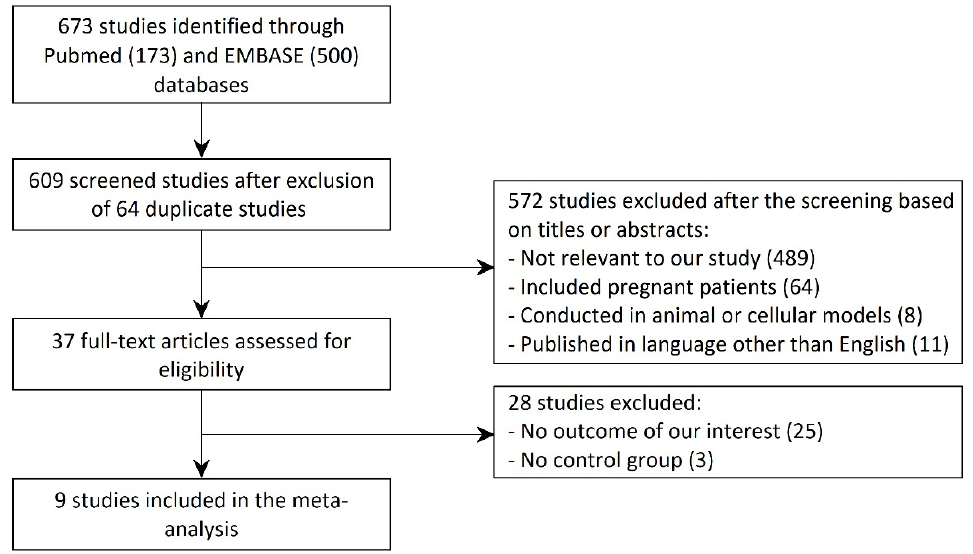
Figure 1. PRISMA (Preferred Reporting Items for Systematic Reviews and Meta-Analyses) flow diagram for identification, screening, eligibility, and inclusion of studies.